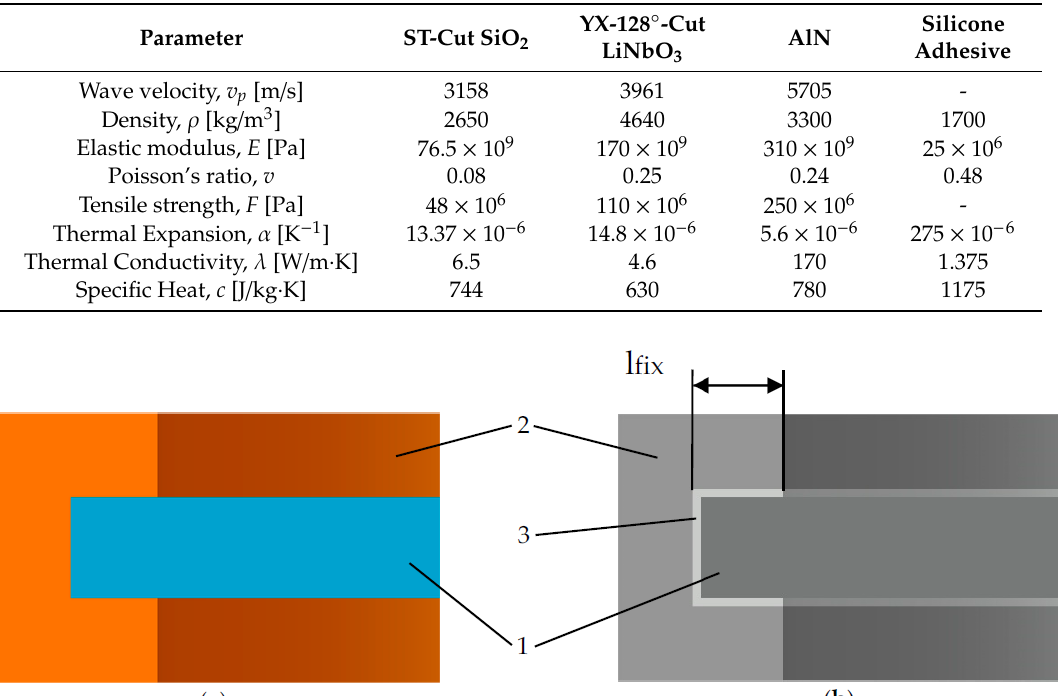
Table 1. Characteristics of piezoelectric materials and silicone adhesive.